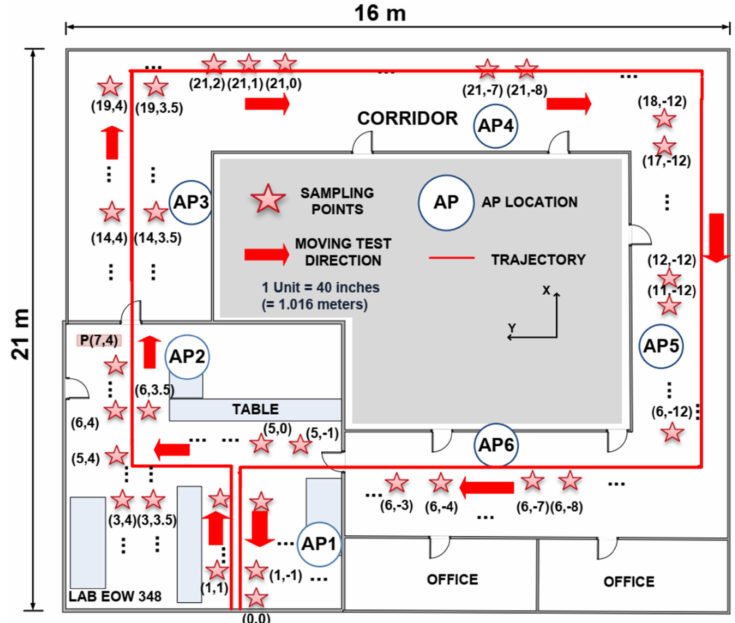
Figure 8. Experiment in the engineering office wing at University of Victoria, considering open datasets [27]. The six access points were located at the AP circles.